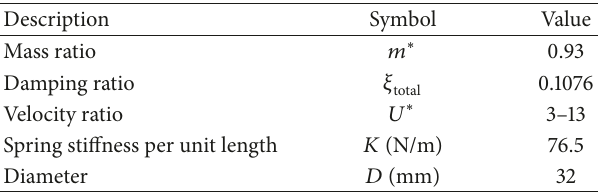
Table 3: Physical model parameters for the simulation.